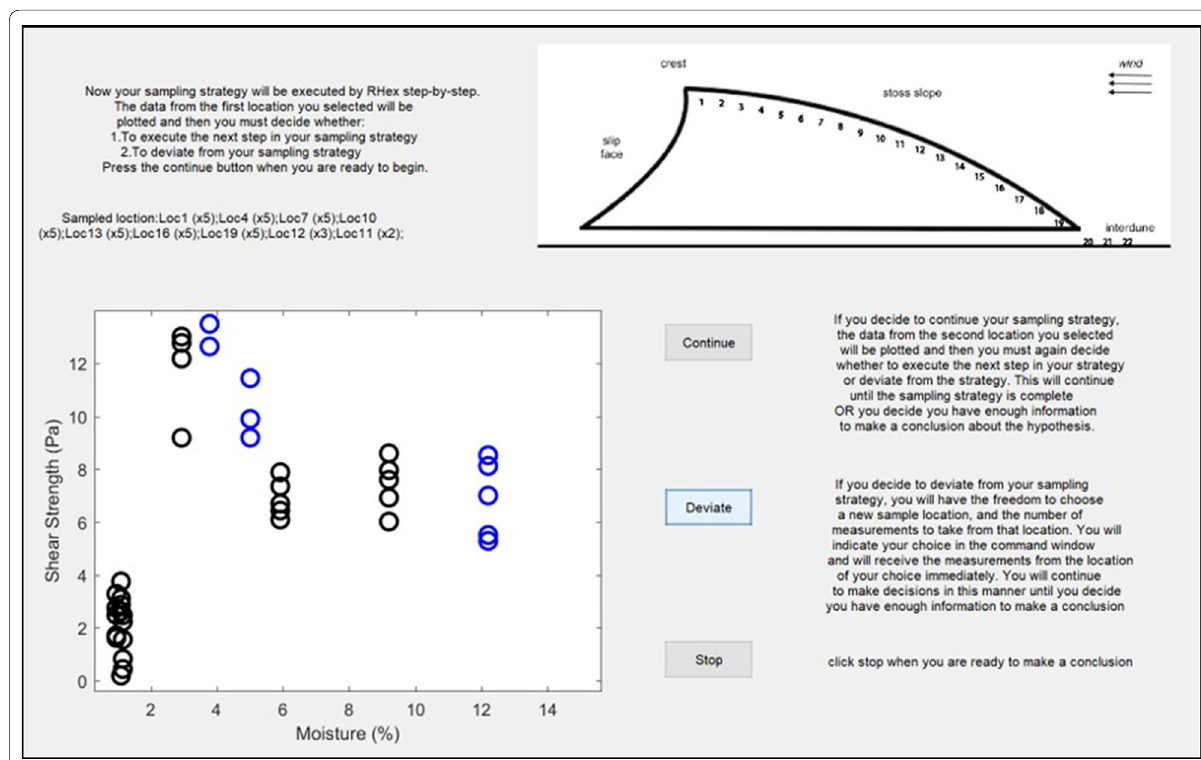
Fig. 3 Decision-making scenario MATLAB user interface. After reporting an initial sampling strategy to the experimenter using the diagram of the dune cross-Sect. (22 possible locations, up to 10 measurements at each location), participants plotted their measurement data one location at a time by pressing the “Continue” button. Data points appeared in black on the moisture-strength scatterplot (lower left), and visited locations were recorded in text just above the scatterplot along with the number of measurements taken, e.g., Loc1 ( strategy at any point by pressing the “Deviate” button and reporting a new location to the experimenter—data from this location were plotted immediately (in blue). When participants were ready to make a conclusion about the hypothesis they pressed the “Stop” button. The user interface code is available online: https:// osf. io/